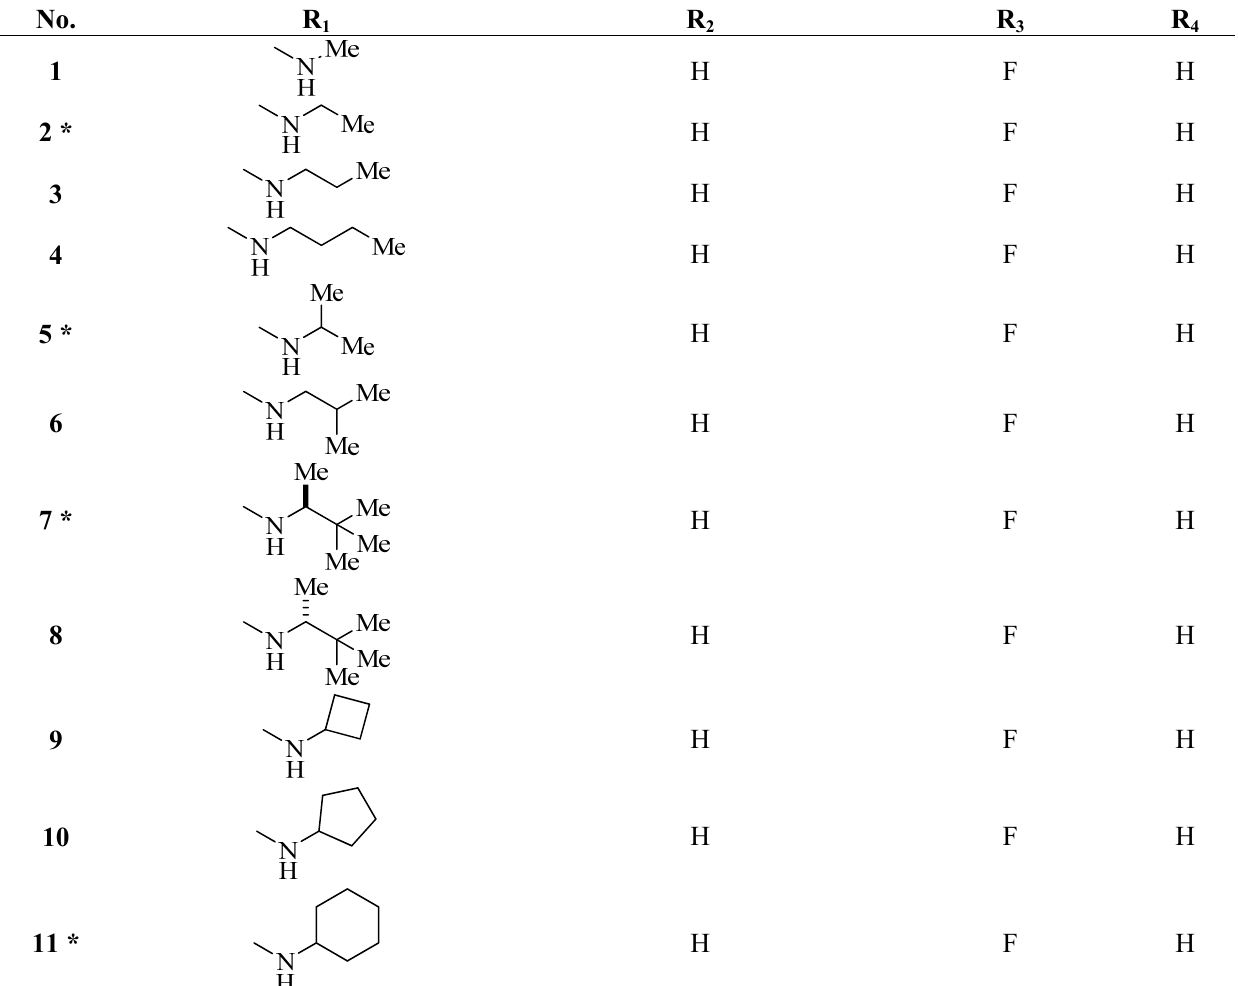
Table 5. The molecules of 5 H -pyrido[4,3-b]indol-4-carboxamide